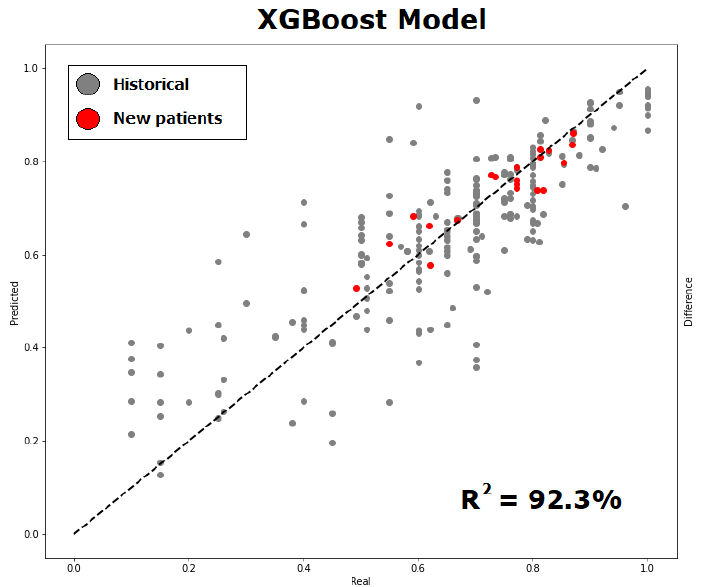
Figure 5. Probability of cardiovascular rehabilitation (predicted versus observed values) using the proposed methodology of incorporating new variables into the retrospective data, observing that new data (in red) contributes to a good adjustment of prediction. The graph shows the best performance result